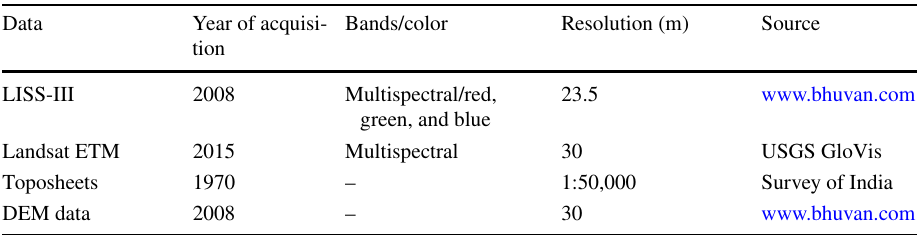
Table 1 Satellite data